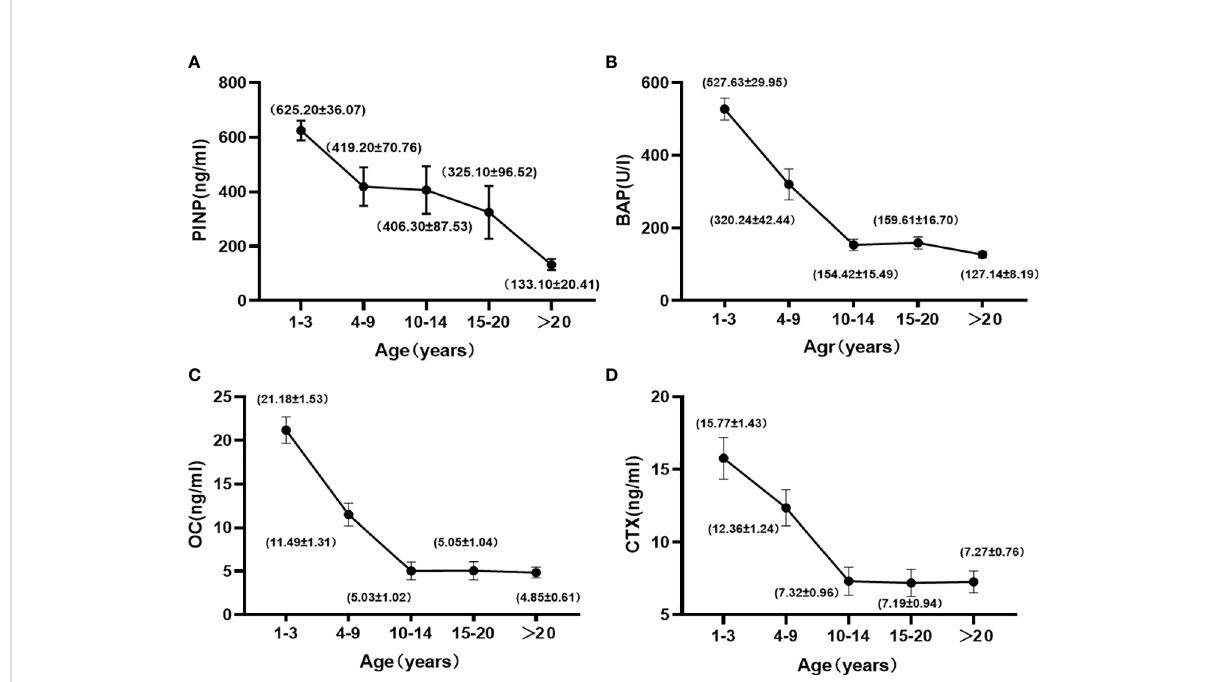
FIGURE 1 Changes in the PINP (A) , BAP (B) , OC (C) , and CTX (D) with age in female cynomolgus monkeys. Data are represented as means ± SEM.